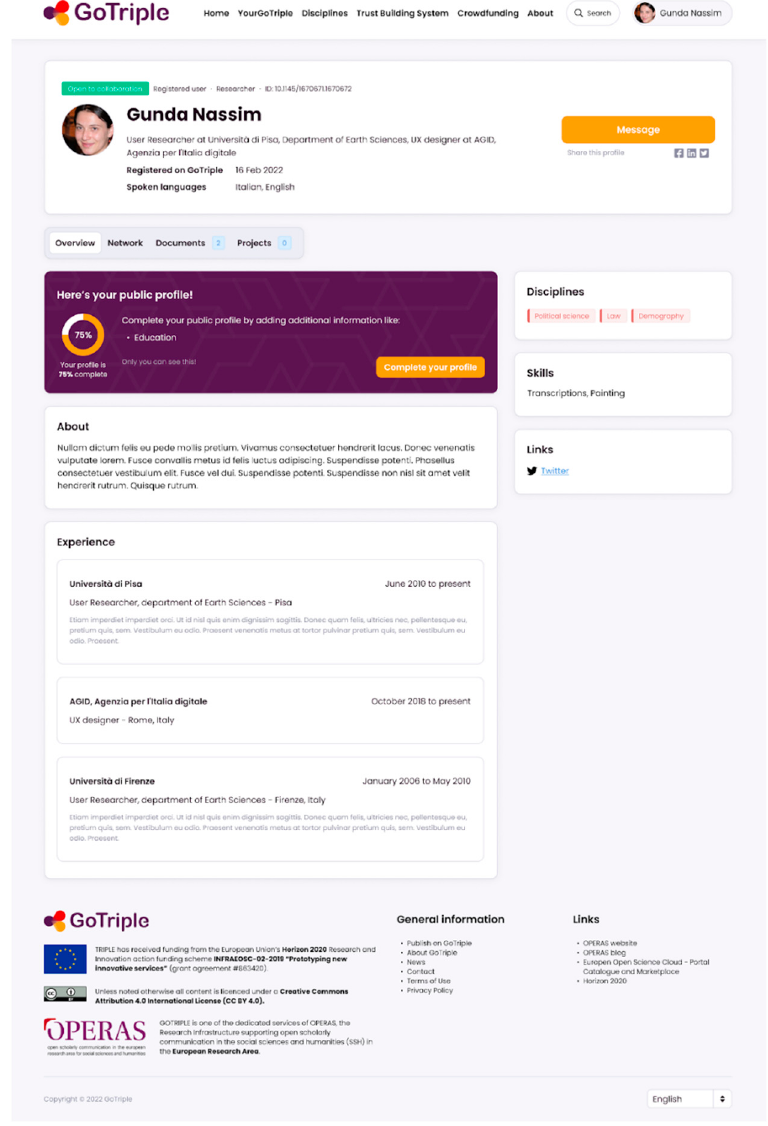
Figure 3. Example of a completed user profile on GoTriple.